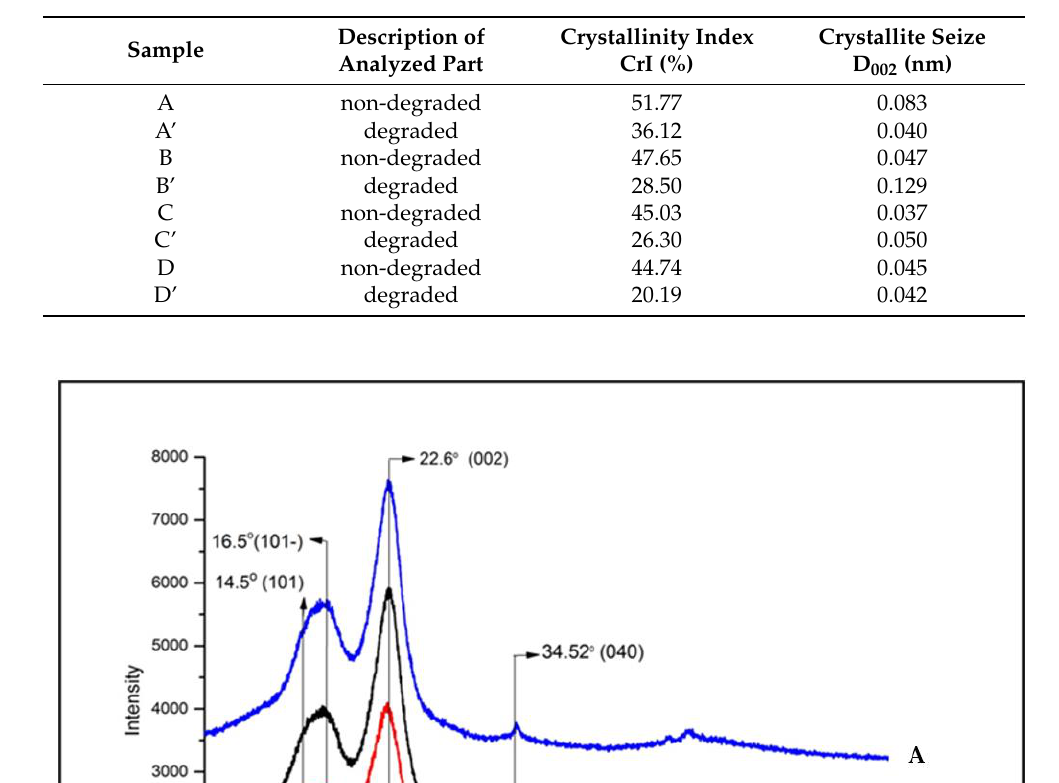
Table 3. Crystallinity indices values (CrI %) and crystallites seize: degraded and non-degraded wood samples.